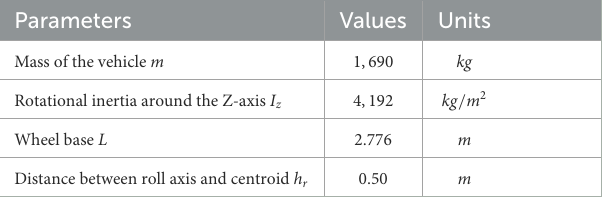
TABLE 1 Partial parameter setting of the vehicle model.